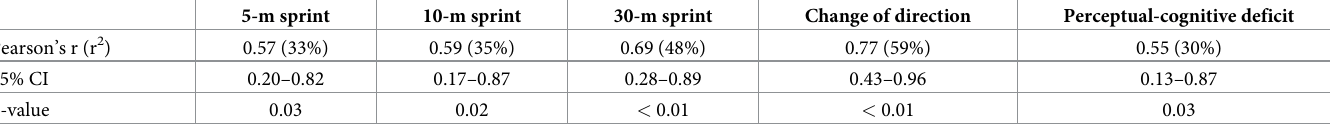
Table 2. Pearson’s r (r2), 95% CI and p-values for correlations between agility and 5-m sprint, 10-m sprint, 30-m sprint, change of direction performance, and per- ceptual-cognitive